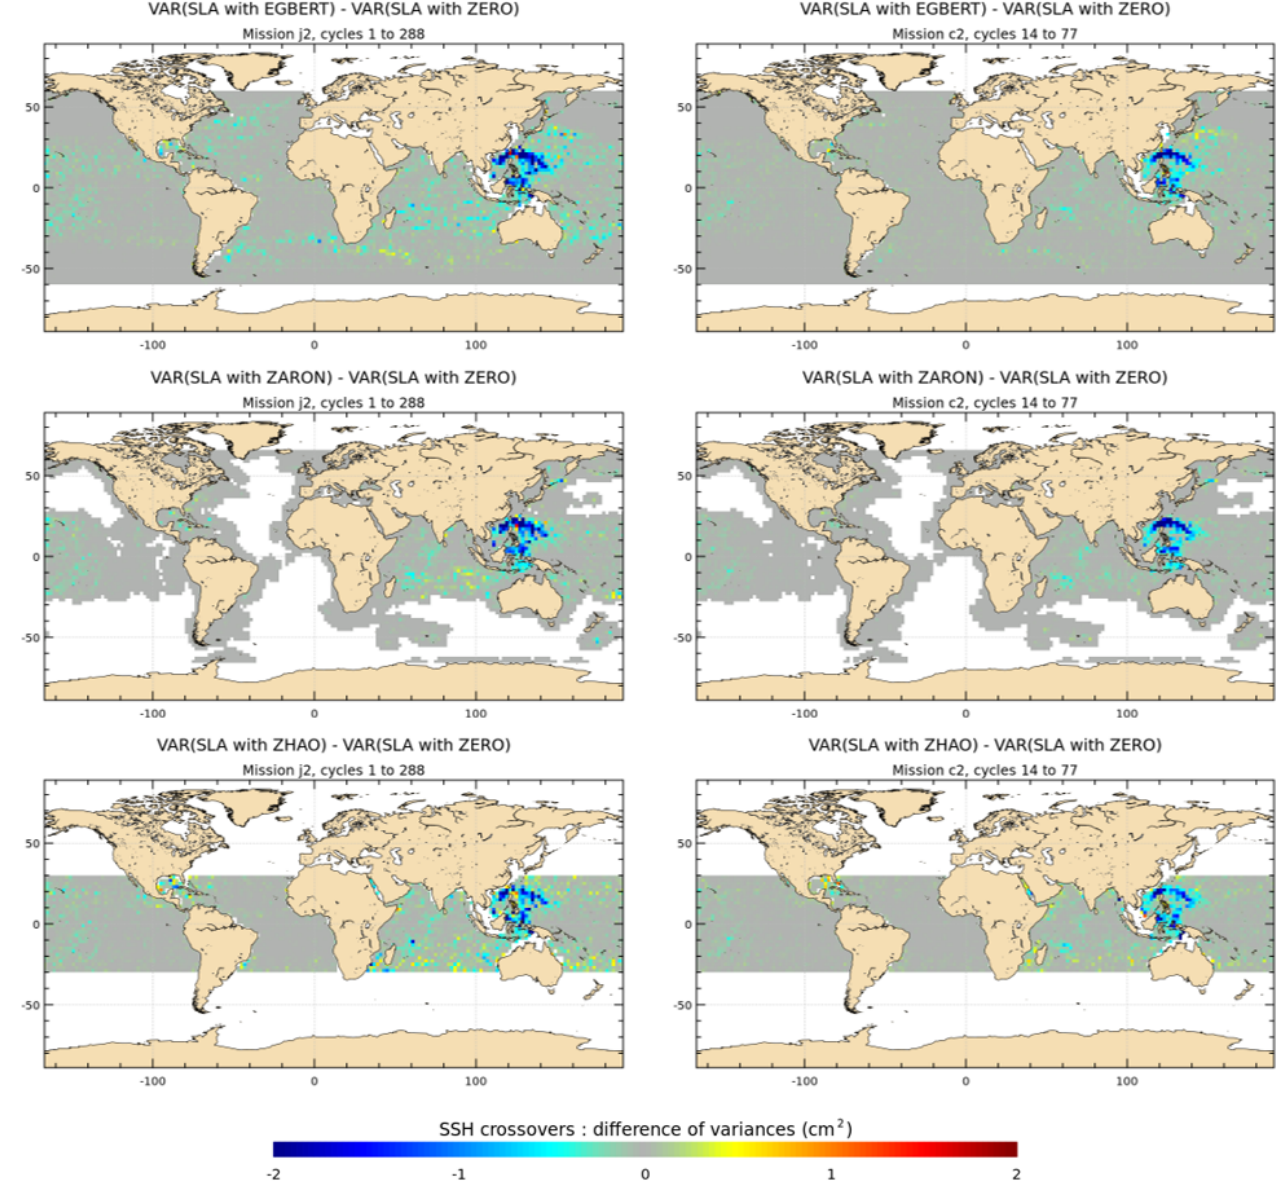
Figure 12. Maps of SLA variance differences using either the K 1 IT correction from each model or a reference ZERO correction in the SLA calculation for the J2 and C2 missions (cm 2 ). J2 cycles 1–288 have been used; C2 cycles 14–77 have been